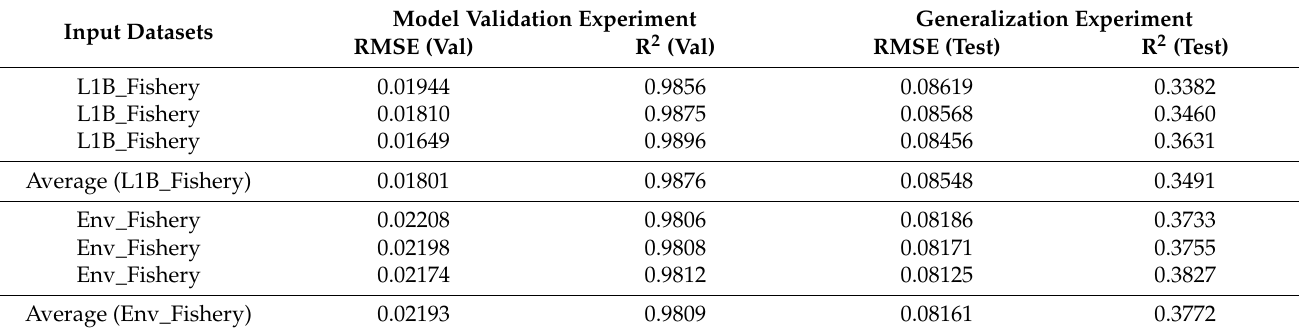
Table 3. The model-validation-experiment and generalization-experiment results of two heteroge- neous data feature-extraction models with L1B_Fishery and Env_Fishery datasets as input. Input